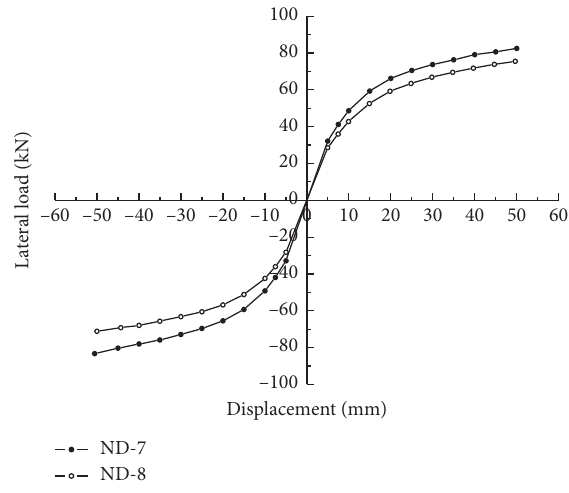
Figure 32: Skeleton curves of slit width 30mm.